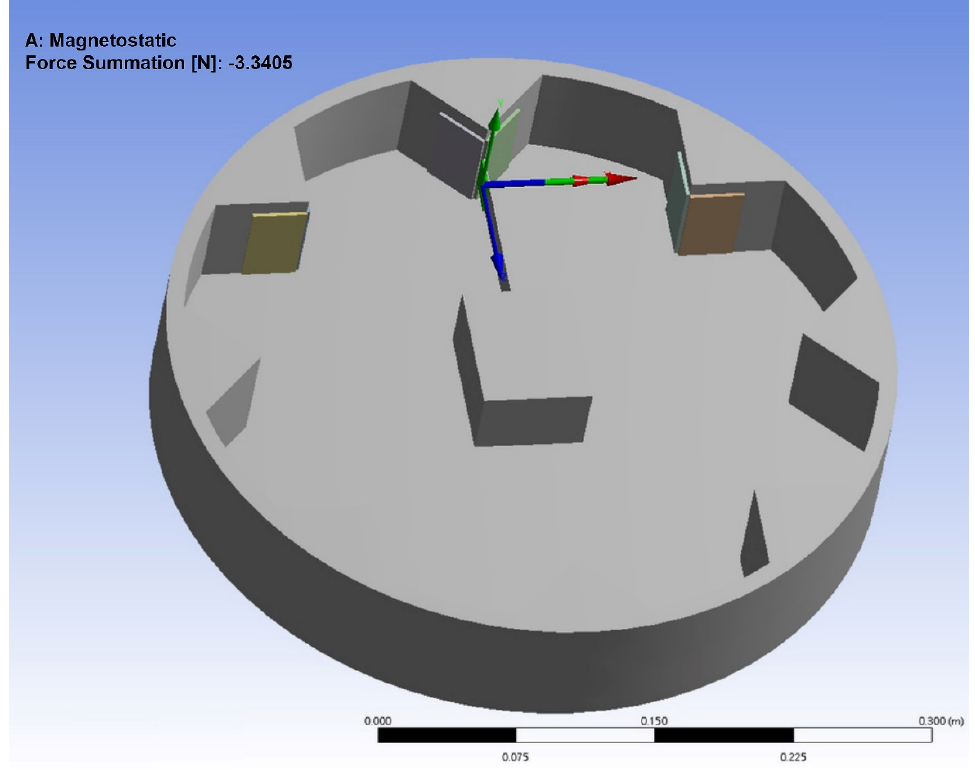
Figure 6. The sum of the force of the magnet.